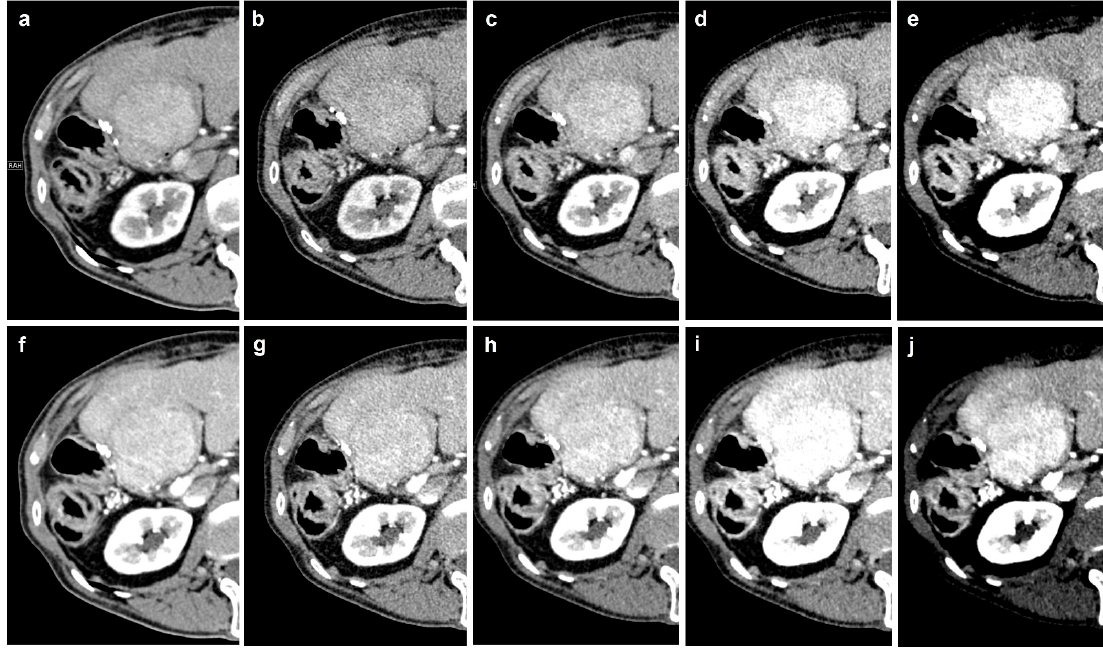
Figure 1. Example of the di ff erent reconstructions in an HCC lesion: ( a – e ): arterial phase imaging (T3D, 70 keV, 60 keV, 50 keV, 40 keV); ( f – j ) portal venous imaging (T3D, 70 keV, 60 keV, 50 keV, 40 keV).